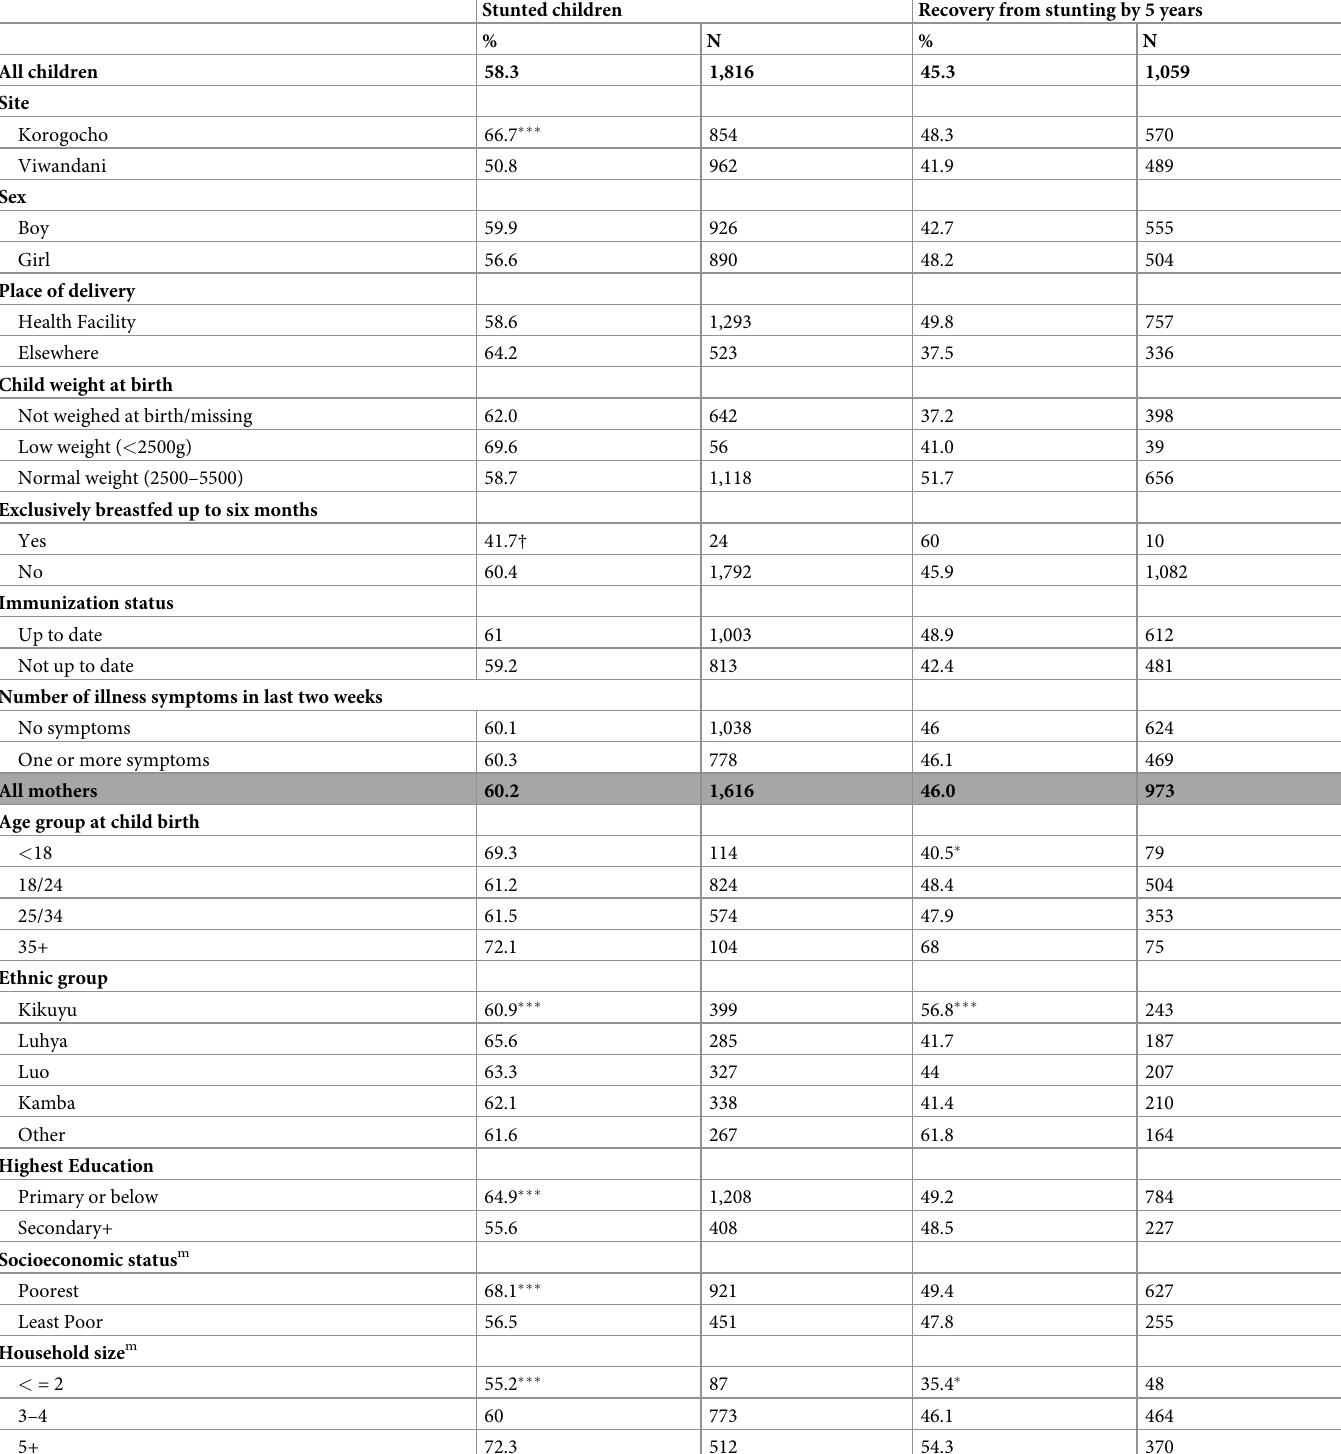
Table 2. Percentage of children who were stunted by five years and, among them, the percentage who recovered from stunting before five years, background charac- teristics at the time of recruitment. Stunted children Recovery from stunting by 5 years % N % N All